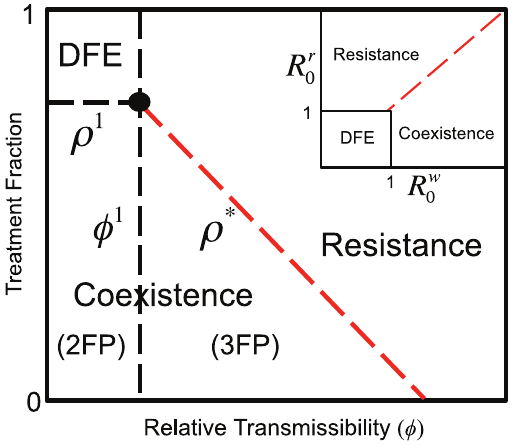
) parameter , R r 0 0